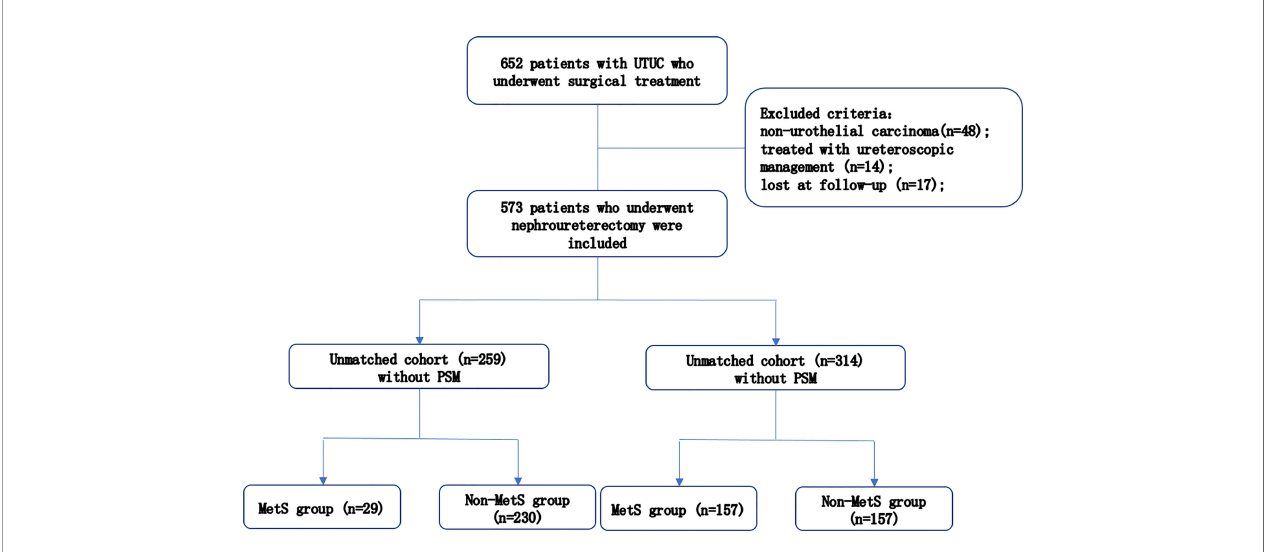
FIGURE 1 | Patient selection fl